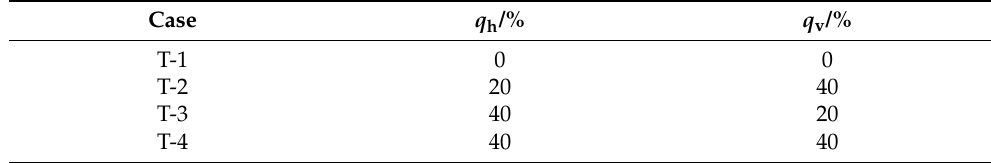
Table 4. Parameters of the simulated test set.